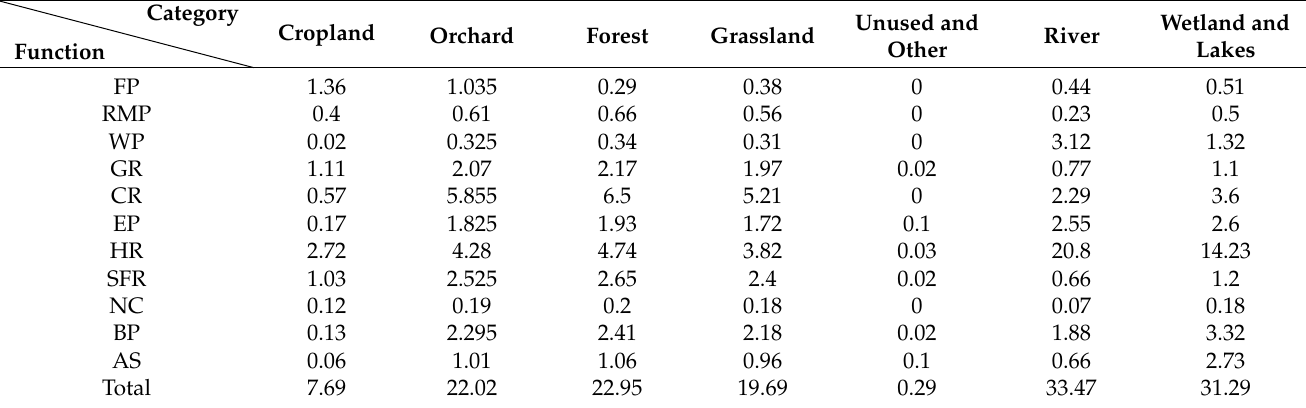
Table 2. Basic reference standard ecosystem service equivalent value (ESEV) table